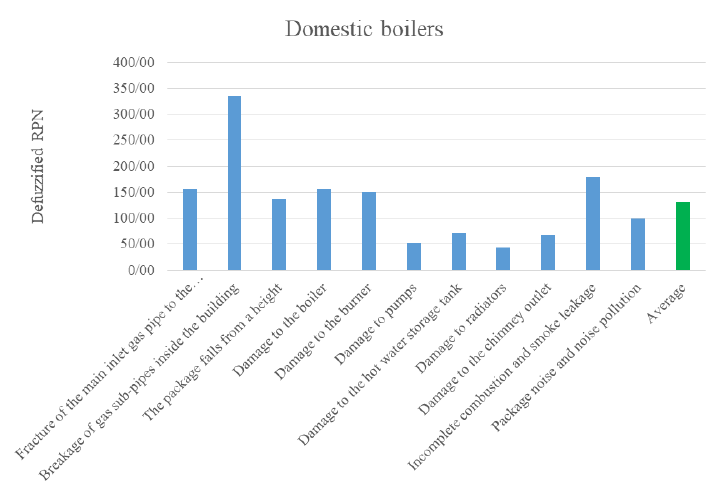
Figure 3 . Defuzzified RPN values for the risk of